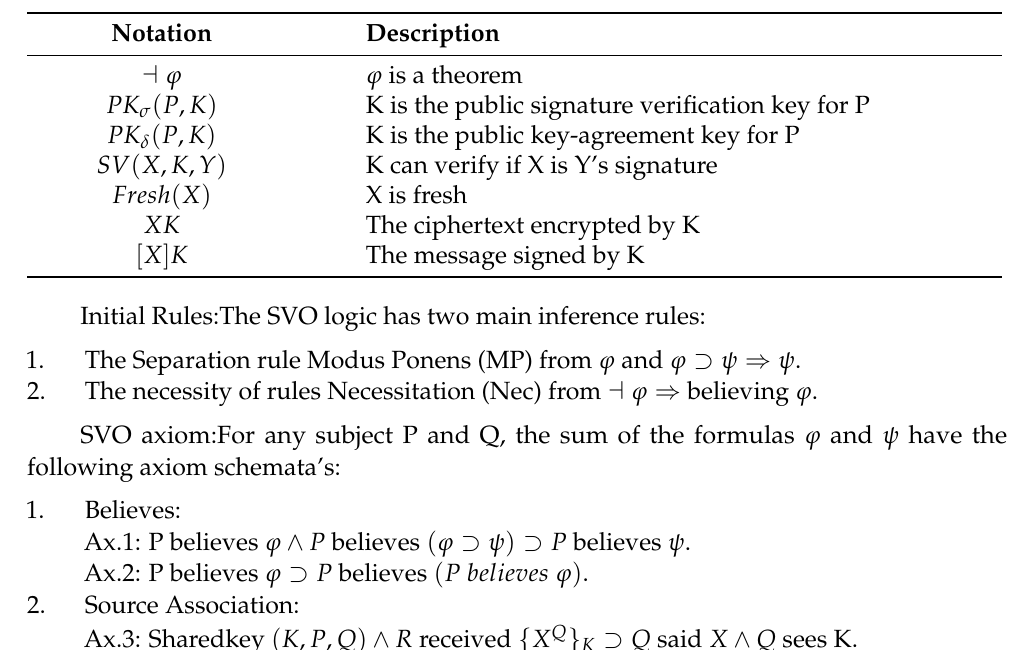
Table 4. The SVO logic notation and the corresponding